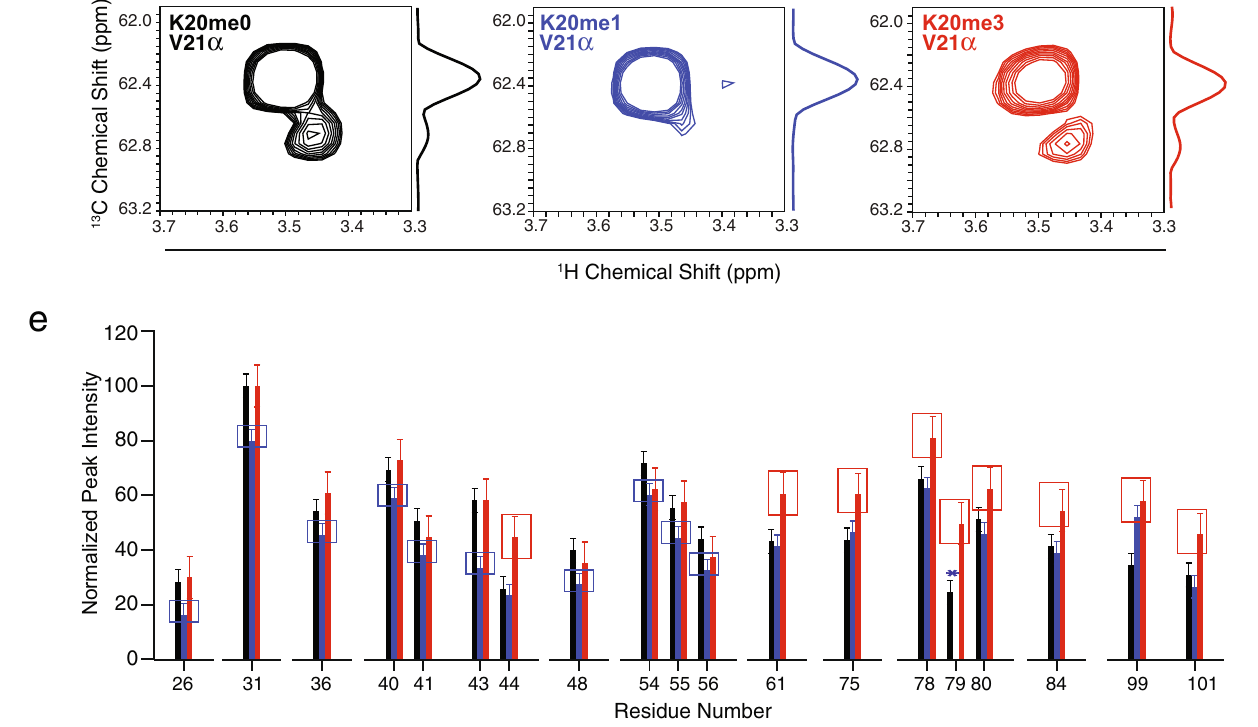
H4 protein backbone at the μ s-ms timescale 47,49 . In comparison adjacent stretch of the α 1 and α 2 regions (Fig. 6e and with the H4K20me0 nucleosome array, the globular domain of Supplementary Fig. 15a, b). This implied that these core regions the H4K20me1 array showed more uniform peak intensities of H4K20me1 were more mobile compared to the H4K20me0 across the protein and reduced relative intensities for several arrays, likely related to a higher fl exibility of DNA. In contrast, residues primarily residing in the LN and L1 regions and in the compared with the H4K20me0 arrays, the H4K20me3 construct NATURE COMMUNICATIONS| (2021) 12:4800